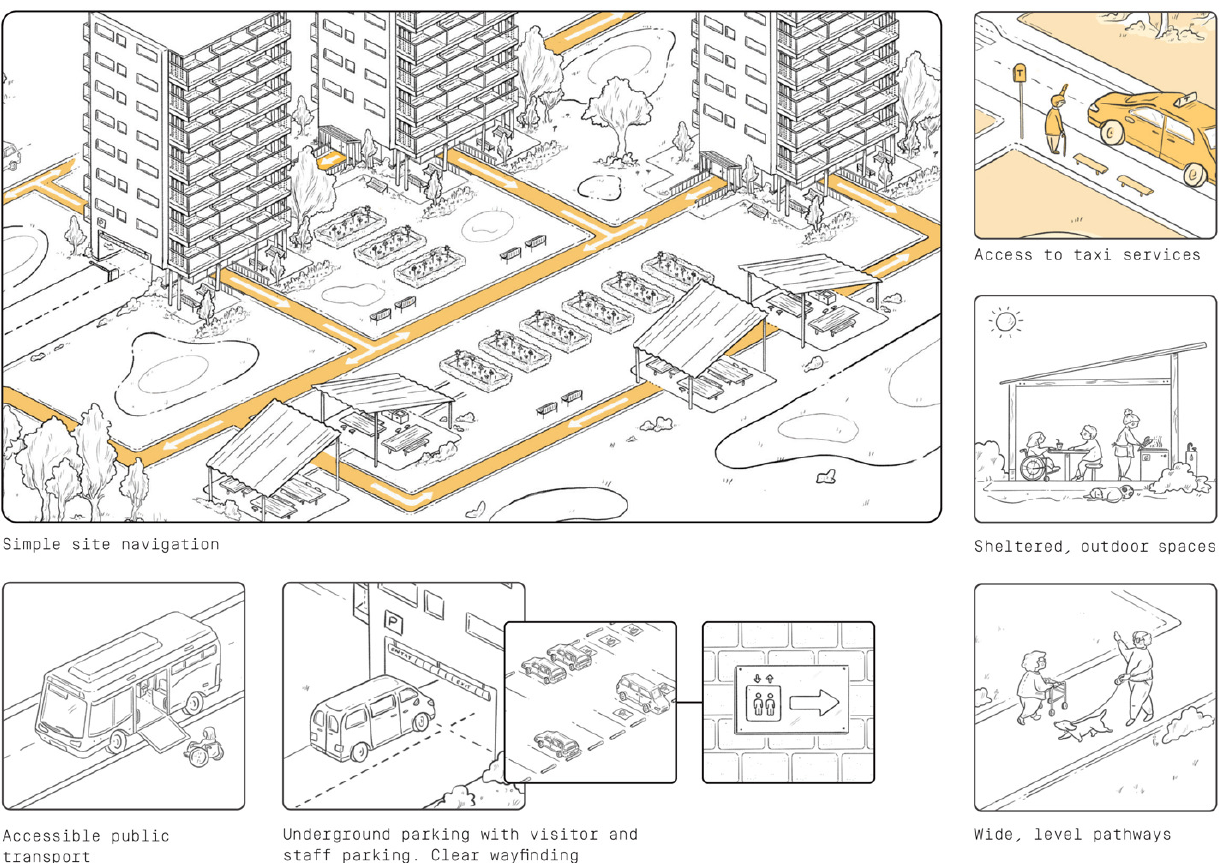
Figure 1. Outdoor urban setting elements that influence the independence of people with intellectual disability and the quality and effectiveness of disability support provided in a community setting. Source: Illustration courtesy of Kristelle de